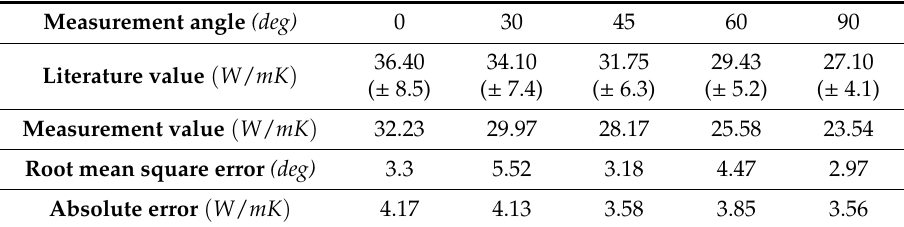
Table 8. Measurement results of A-plane sapphire using collinear deflection